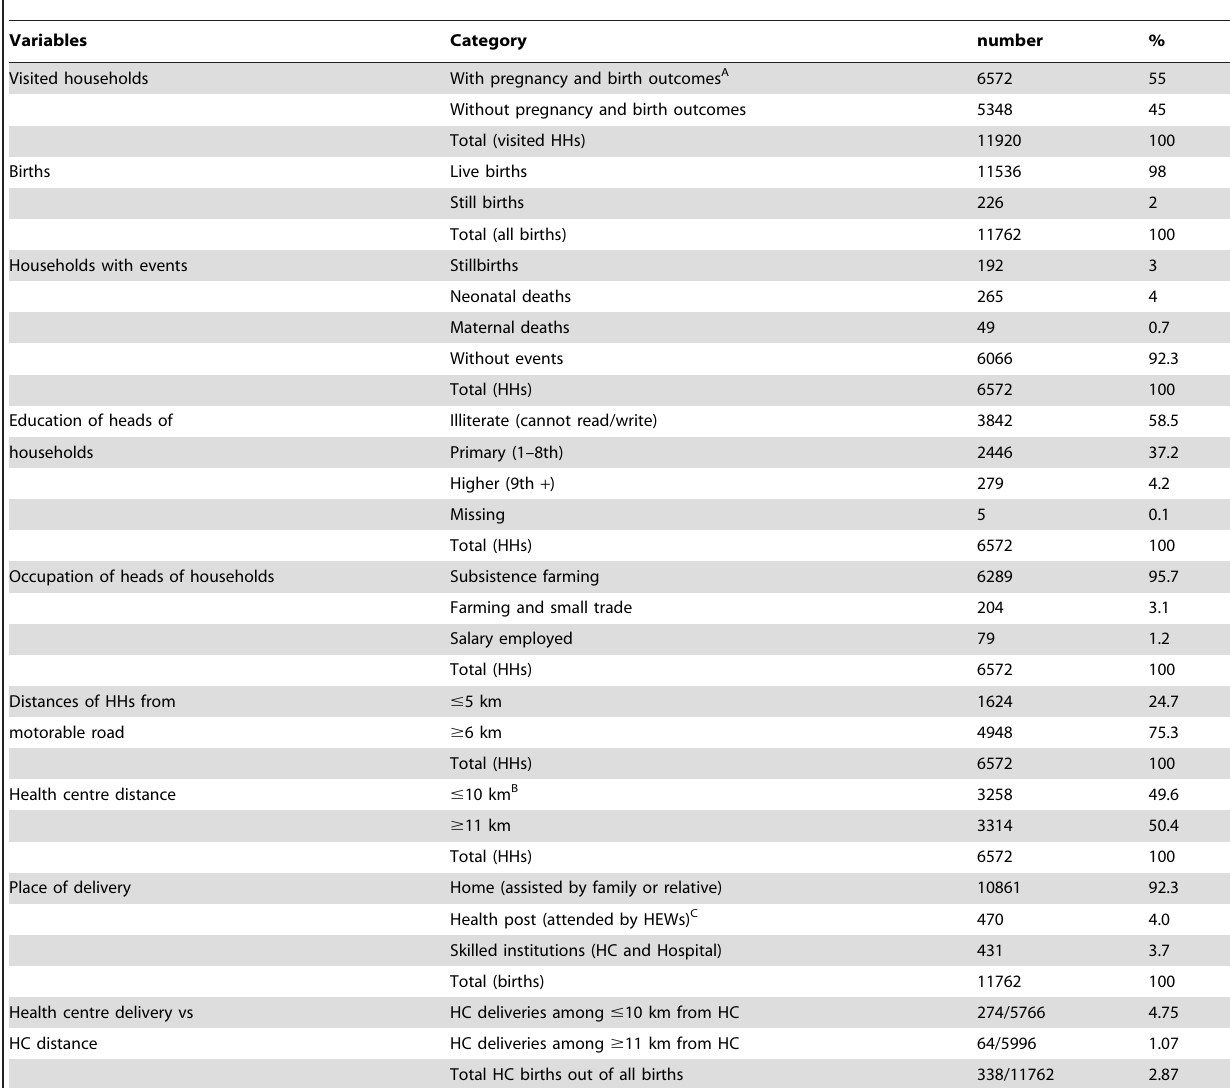
Table 2. Socio-demographic backgrounds of household-survey participants, Bonke, Gamo Gofa, south-west Ethiopia, 2011.